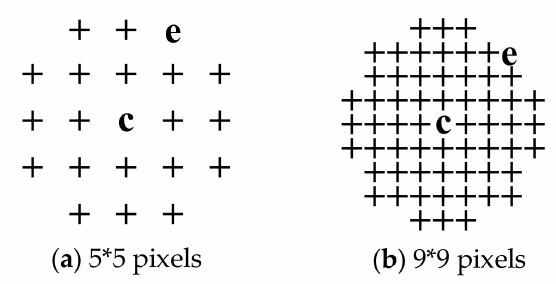
Figure 5. Final neighborhoods with different sizes.